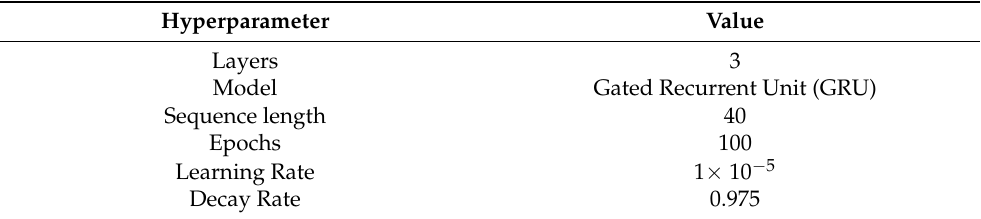
Table 1. Hyperparameters for the Recurrent Neural Network used to generate answers Hyperparameter Value Layers 3